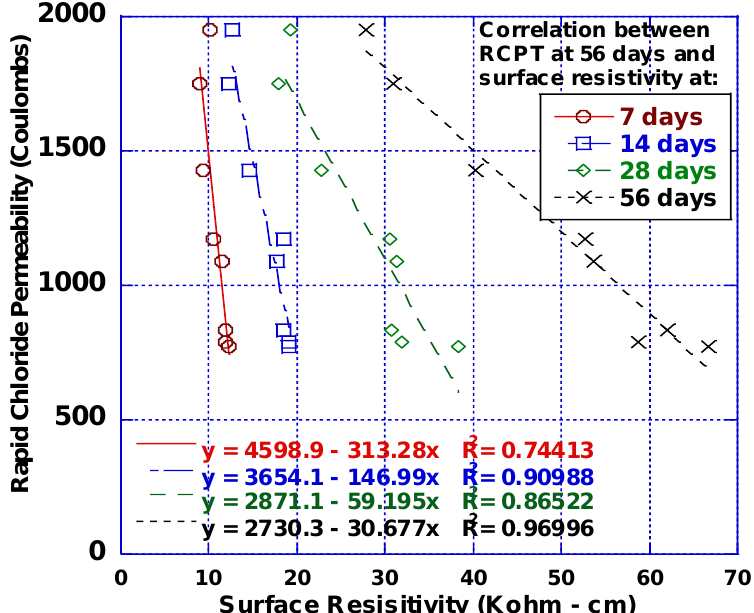
Figure 5. Correlation between the chloride penetrability and surface resistivity.